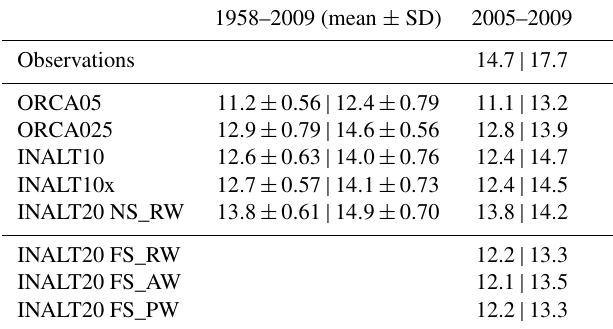
Table 8. MOC transport at 34.5 ◦ S | 26.5 ◦ N (in Sv) averaged over the full integration period (1958 to 2009) and the respective stan- dard deviations (SDs) on interannual timescales and for the period 2005–2009 compared to observations from Meinen et al. (2018) for 34.5 ◦ S and RAPID at 26.5 ◦ N (http://www.rapid.ac.uk/rapidmoc, last access: 24 January 2018), respectively.